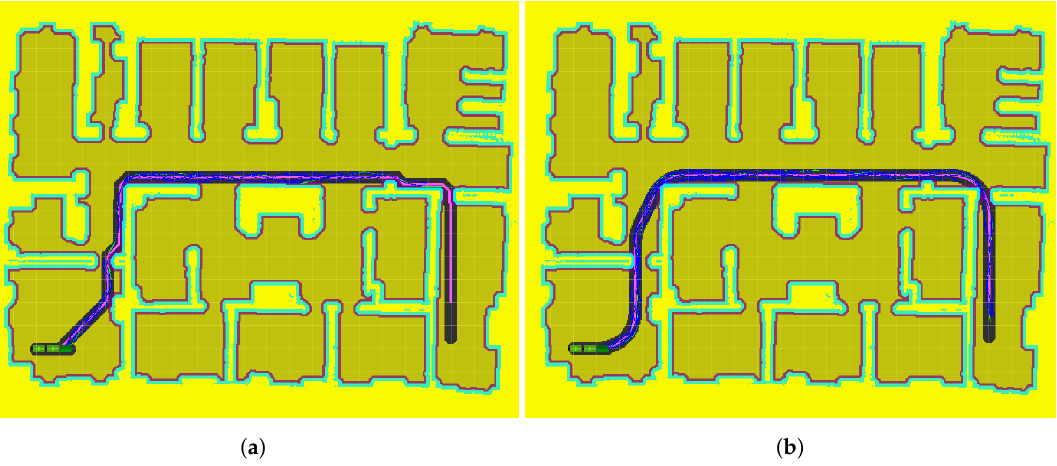
Figure 16. Goal 3 results: ( a ) Path planning with ARA*-RRT*; ( b ) Path planning with LARA*-RRT*.